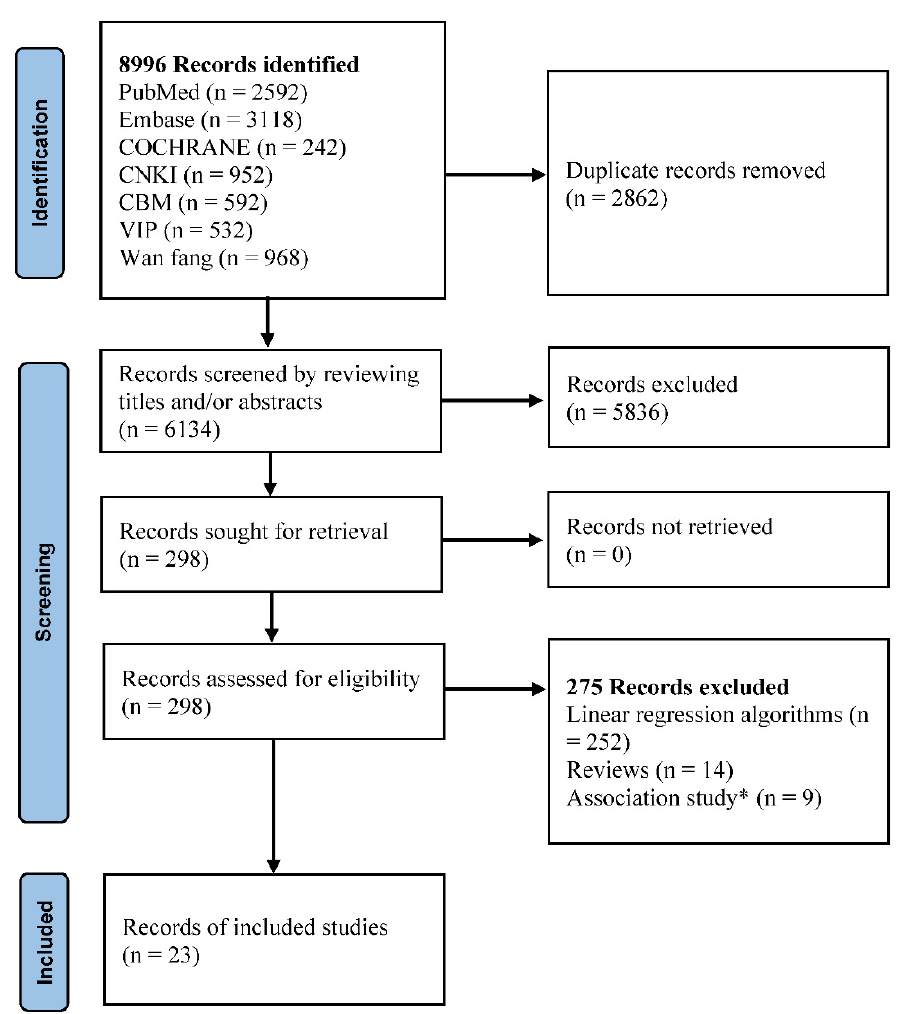
Figure 1. PRISMA flow chart of included studies. * The same research was translated into Chinese and English.